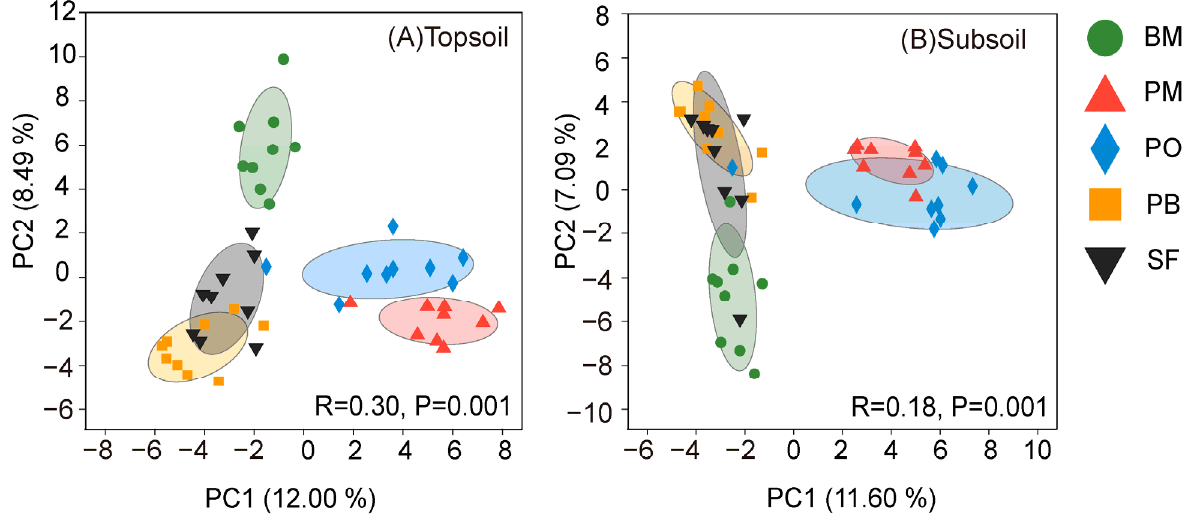
Figure 4. Principal component analysis of fungal communities in different forest types. ( A ) topsoil; ( B ) subsoil. Broadleaf-oriented transformation, BM; P. massoniana mature plantation, PM; P. massoniana overmature plantation, PO; P. massoniana + local broadleaved trees, PB; secondary forests, SF.